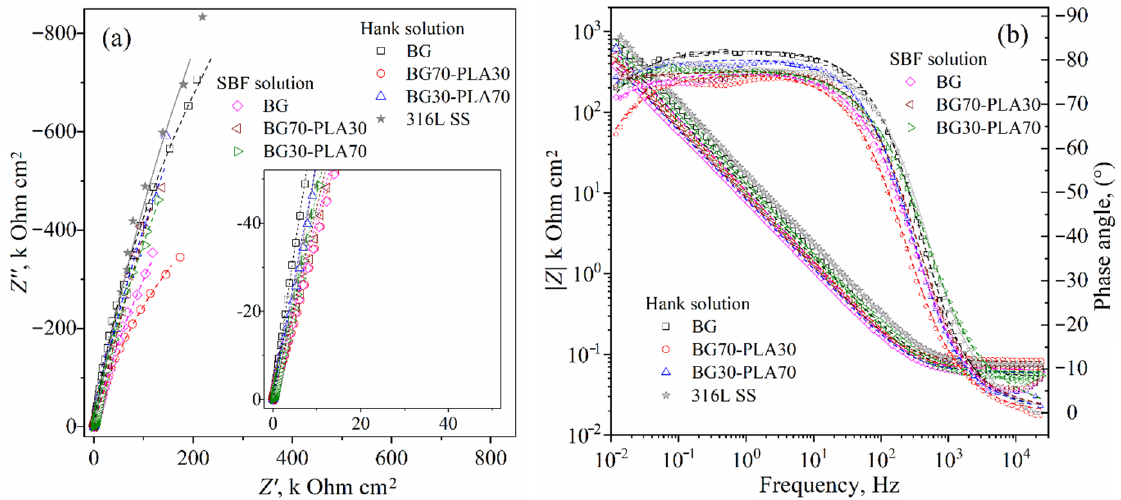
Figure 18. EIS results for BG-PLA coatings obtained after 24 h of immersion in Hank’s and SBF solutions: ( a ) Nyquist and ( b ) Bode plots. Scatter and lines indicate the experimental data and the fitting results, respectively.